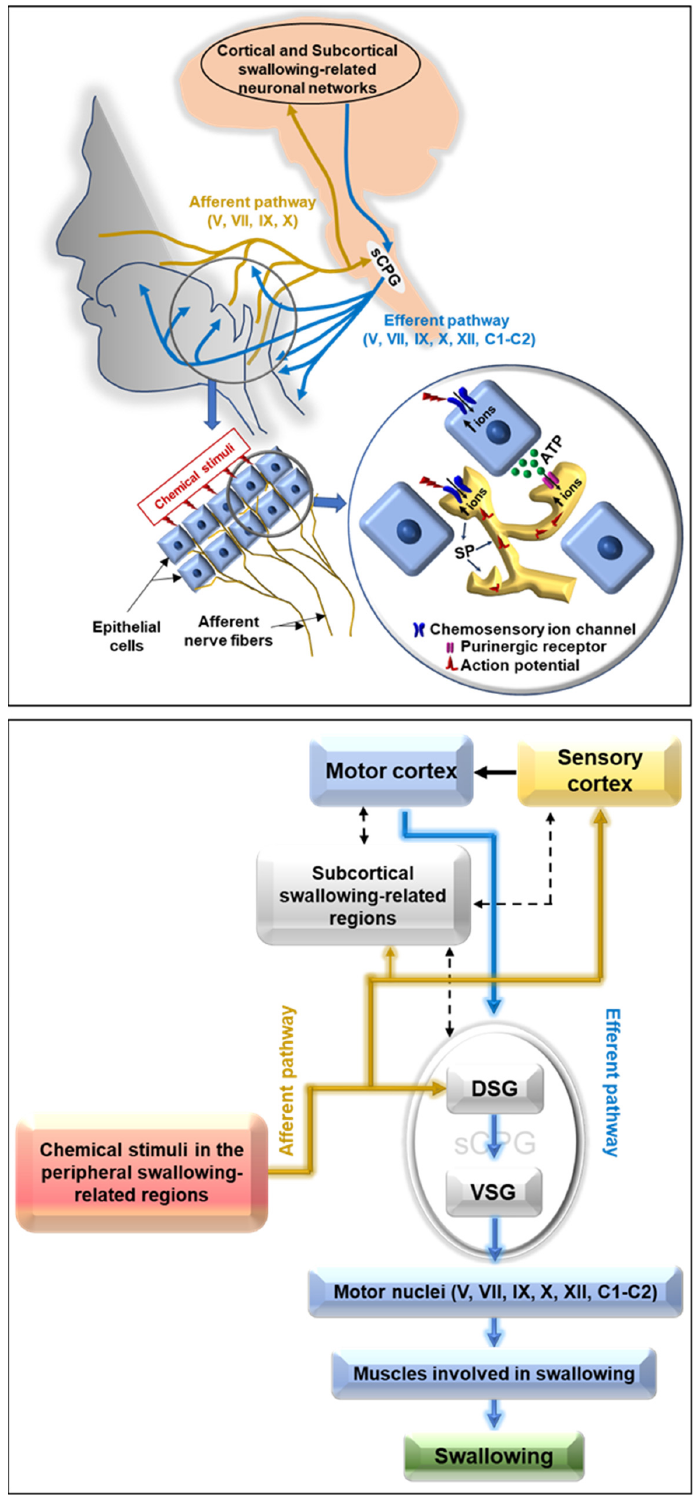
Figure 1. Possible transduction mechanisms and neurophysiological pathways of improving swallowing function via the actions of chemical stimuli applied to peripheral swallowing-related regions. Chemical stimuli applied to peripheral swallowing-related regions can activate chemosensory ion channels expressed in the epithelial cells and nerve fibers in these regions, causing the entry of ions into these structures. The epithelial cells may then release ATP, which can activate purinergic receptors expressed on nearby intra- or sub-epithelial afferent nerve fibers, thus causing the entry of ions into the nerve fibers, leading to the generation of action potentials. Action potentials